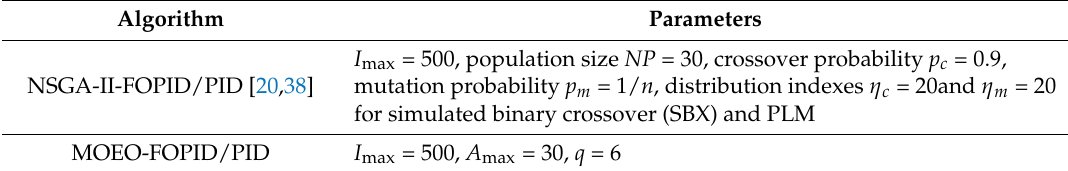
Table 3. The parameters for MOEO-FOPD/PID and NSGA-II-FOPID/PID used in the experiments. Algorithm Parameters NSGA-II-FOPID/PID [20,38]